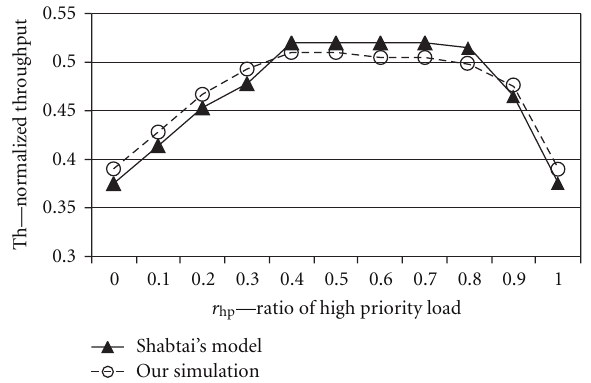
Figure 3: Total normalized throughput of a dual-priority, single- bu ff ered, 6-stage MIN.